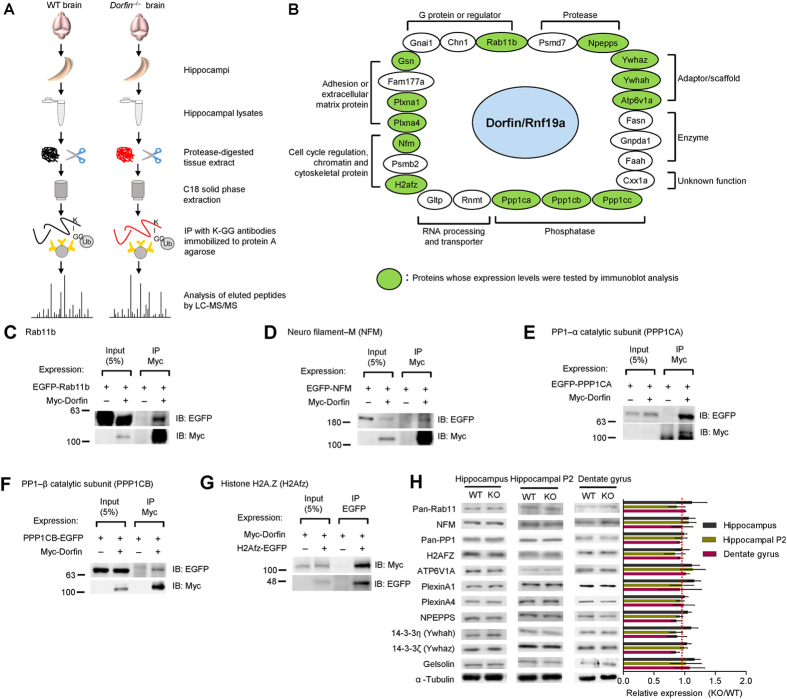
Proteomic identification of proteins with reduced ubiquitination in the Dorfin−/− hippocampus.(A) Procedures for the identification of proteins with altered ubiquitination in the Dorfin−/− brain. Ubiquitinated peptides from hippocampus lysates were immuno-affinity purified with the K-GG antibody, followed by tandem mass spectrometry (LC-MS/MS) analysis for qualitative sequencing, target site identification, and quantification. (n = 6 mice for WT and 8 for KO in one sample respectively). (B) List of proteins whose ubiquitination levels are decreased by >2.5 folds in the Dorfin−/− hippocampus relative to WT controls (see also Supplementary Table 1). Green circles indicate the proteins whose expression levels were tested by immunoblot of hippocampal lysates (see also Fig. 7H). (C–G) Dorfin forms a complex with five selected proteins from the list in Fig. 7B. HEK293 cells doubly expressing Myc-Dorfin and the indicated proteins were immunoprecipitated and immunoblotted with Myc or EGFP antibodies. Rab11b (C), NFM (D), PPP1CA (E), PPP1CB (F) and H2AFZ (G). Input, 5%. (H) Protein expression levels in the Dorfin−/− hippocampus (2–3 months) relative to those in WT controls, as determined by the immunoblot analysis of whole hippocampal lysates, the crude synaptosomal (P2) hippocampal fraction, and microdissected whole DG lysates. (s.e.m., n = 3–6 for WT and KO hippocampi).